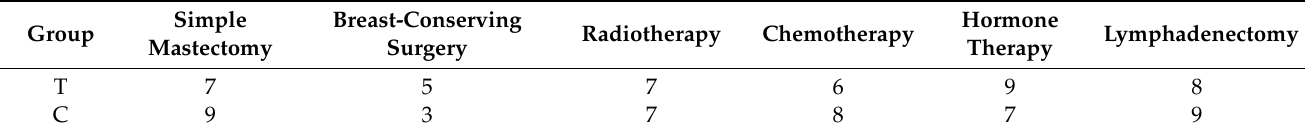
Table 1. Treatment applied in training group (T) and control group (C).